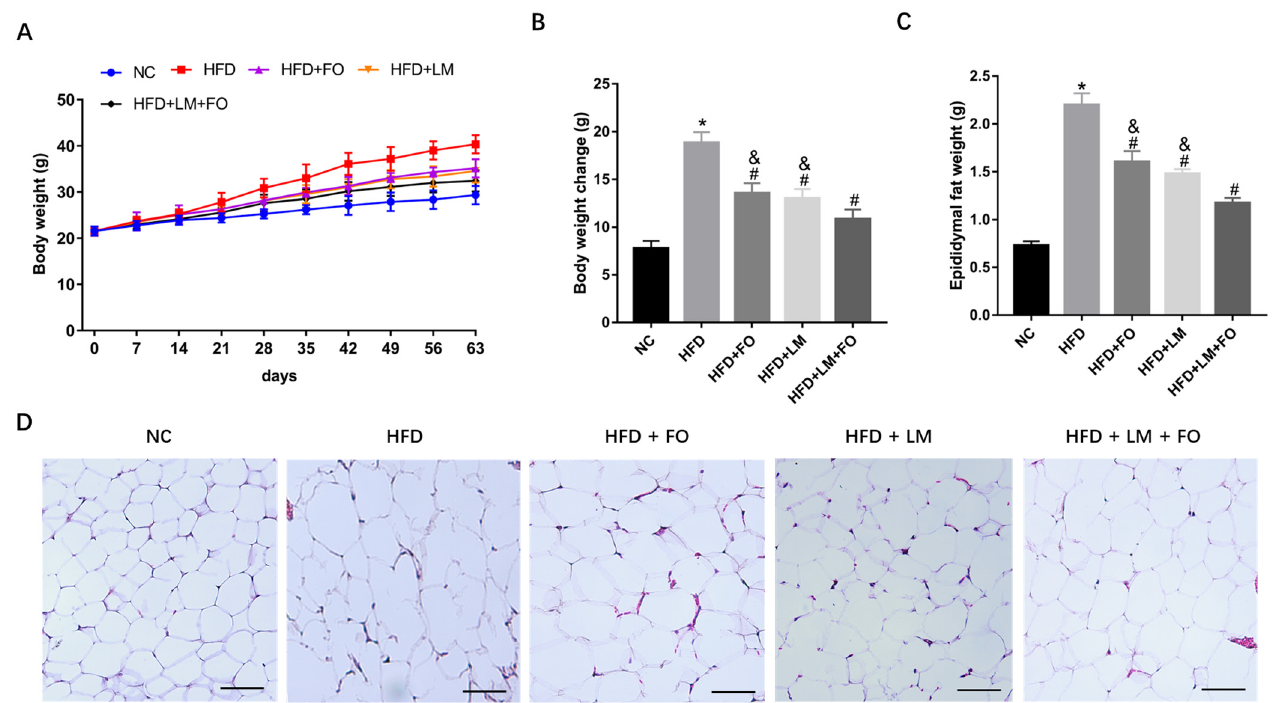
Figure 1. Effects of FO and LM on body weight and adipose tissue in HFD mice. Male C57BL/6J mice were randomly grouped into NC (sterile saline), HFD (sterile saline), HFD + FO (FO at 250 mg/kg), HFD + LM (LM at 10 µ g/kg), and HFD + LM + FO (FO at 250 mg/kg and LM at 10 µ g/kg), and orally administrated daily for 9 weeks. ( A ) Body weight was recorded per week during the experiments. ( B ) Body weight gain, ( C ) adipose weight, and ( D ) H&E staining of epididymal adipose tissue (200 × , scar bar = 100 µ m) were measured after the 9-week treatment period. Data are presented as means ± SD ( n = 8). * p < 0.05 vs. NC; # p < 0.05 vs. HFD; & p < 0.05 vs. LM +